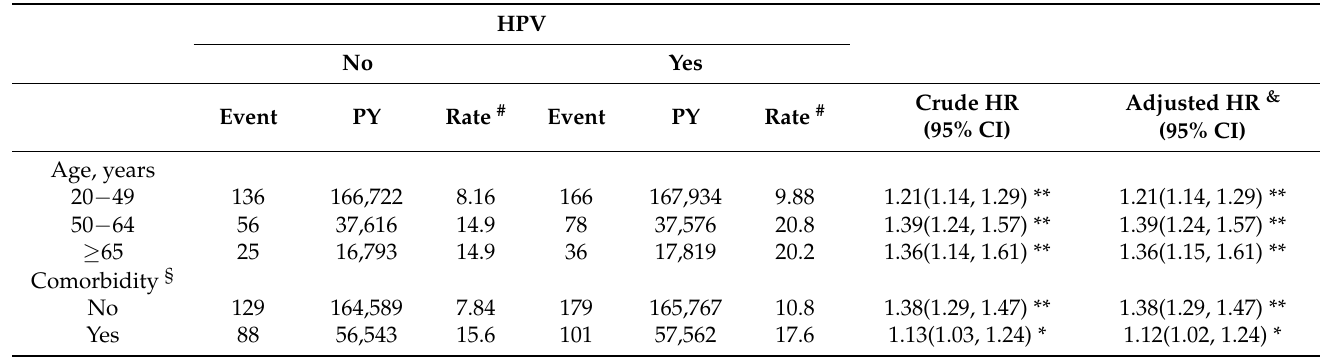
Table 3. Incidence and HRs of breast cancer in individuals with and without HPV.